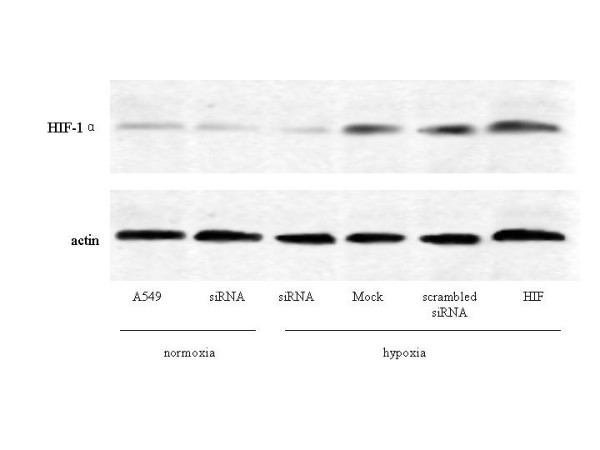
Suppression and over-expression of HIF-1α: western analysis. A549 cells were transfected with HIF-1α siRNA vector or a HIF-1 expression plasmid. Cells were allowed to recover in regular culture medium for 20 h after transfection, then exposed to normoxia or hypoxia for 24 h, at which point cellular protein extracts were prepared (n = 5 in each group). Proteins were separated by SDS-PAGE and transferred to membrane for western blot analysis. siRNA: HIF-1α plasmid transfected, Mock: mock transfected, HIF: HIF-1α expression plasmid transfected.